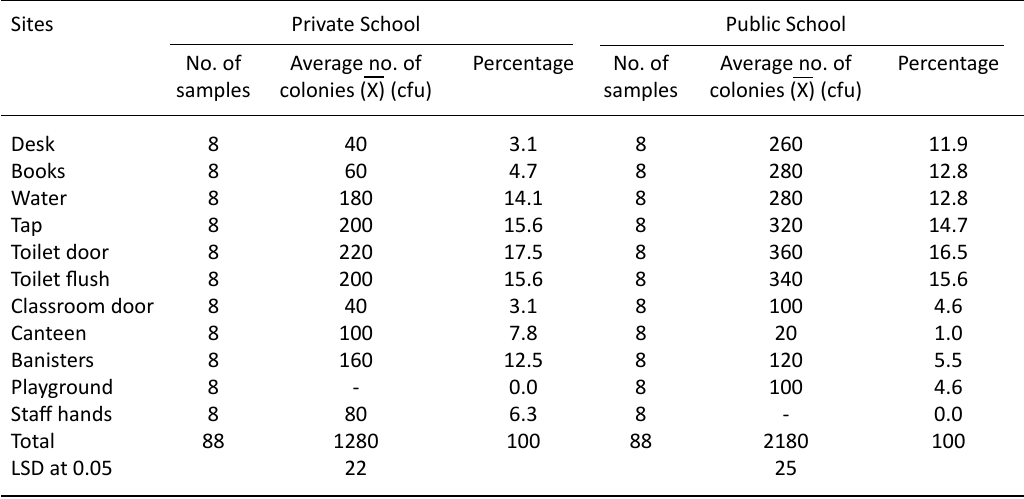
table 1. Microbial total counts produced from different sites, in the two schools